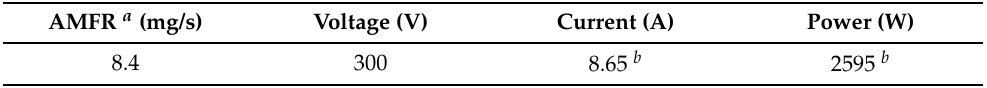
Table 1. HT5k DM2 (M1) operating condition selected for